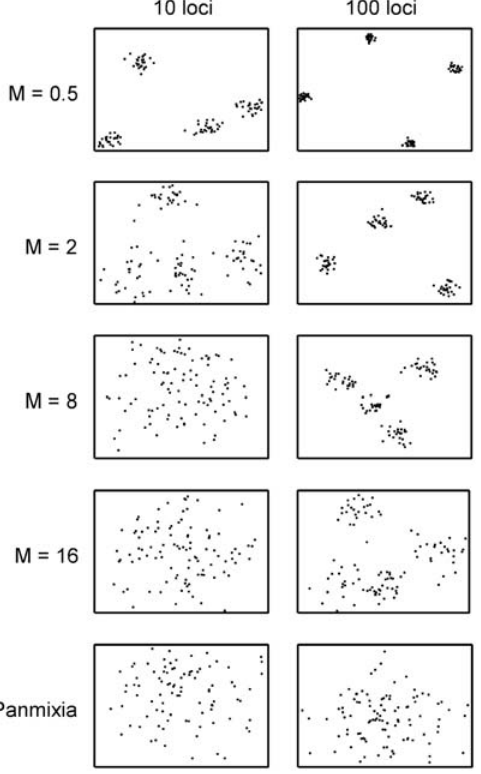
Figure 4. Range of variation and admixture encountered in simulated data sets as viewed by PCO. Number of subpopula- tions=4 for all rows of graphs except the last, where a single, panmictic population was simulated. Migration rate (M) is specified at left. Mutation rate ( h )=0.5. Representative plots of the first two principal coordinate axes are shown. When population structure is present, adding loci increases the density of points within a cluster, permitting more accurate inference.